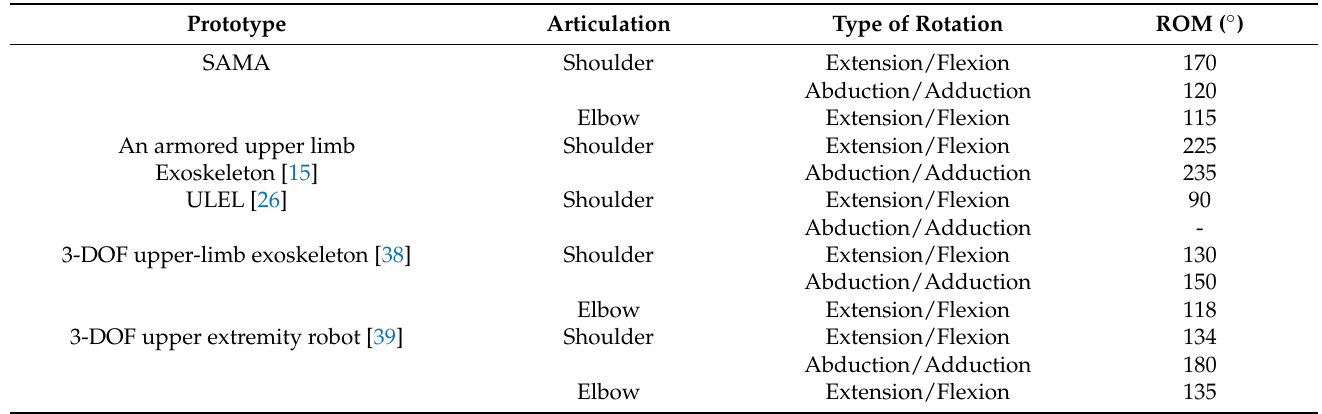
Table 3. ROM of SAMA exoskeleton joints compared to other upper limb exoskeletons.